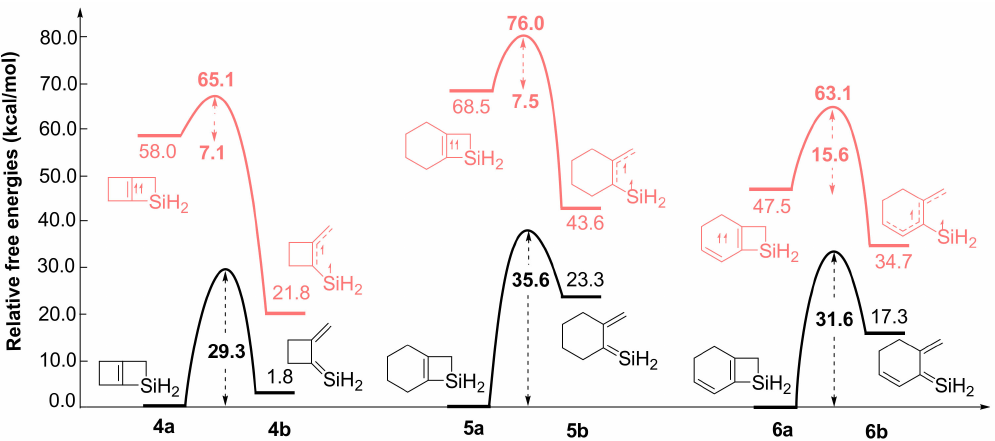
Figure 4. Relative reaction and activation free energies (kcal/mol) for the SCB ring-opening when fused to non-aromatic rings. The energies for transition states are given in bold. Black energy levels represent the S 0 state and red ones represent T 1 states at (U)B3LYP/6-311G(d,p) level.